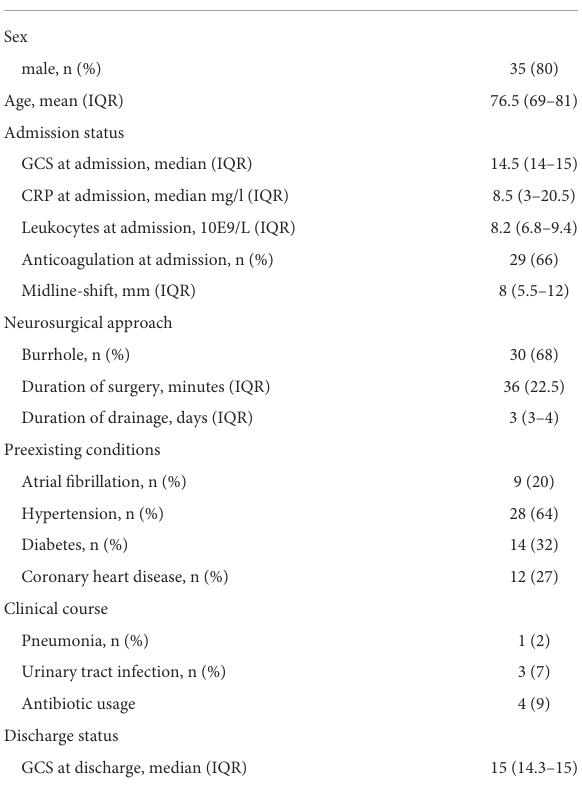
TABLE 1 Demographics, management, and surgical